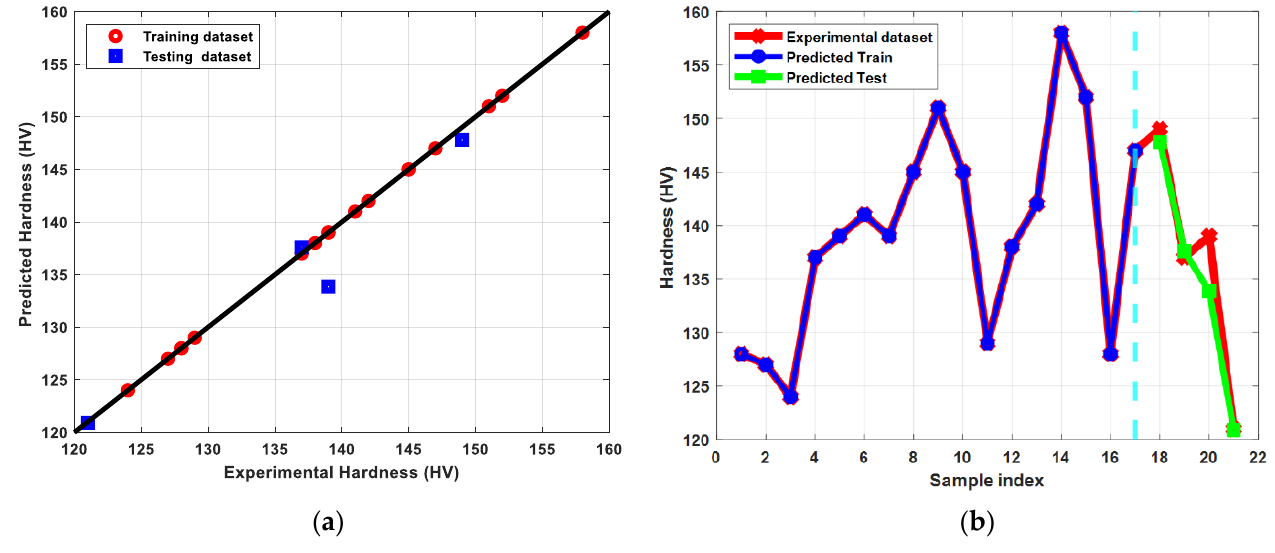
Figure 8. ( a ) Predicted versus experimental hardness evaluated for the training and the testing sets, ( b ) Predicted hardness versus sample index plotted for predicted train, predicted test, and experi- mental hardness. Table 3. Evaluation metrics of Hardness machine learning models for both the training and testing sets.